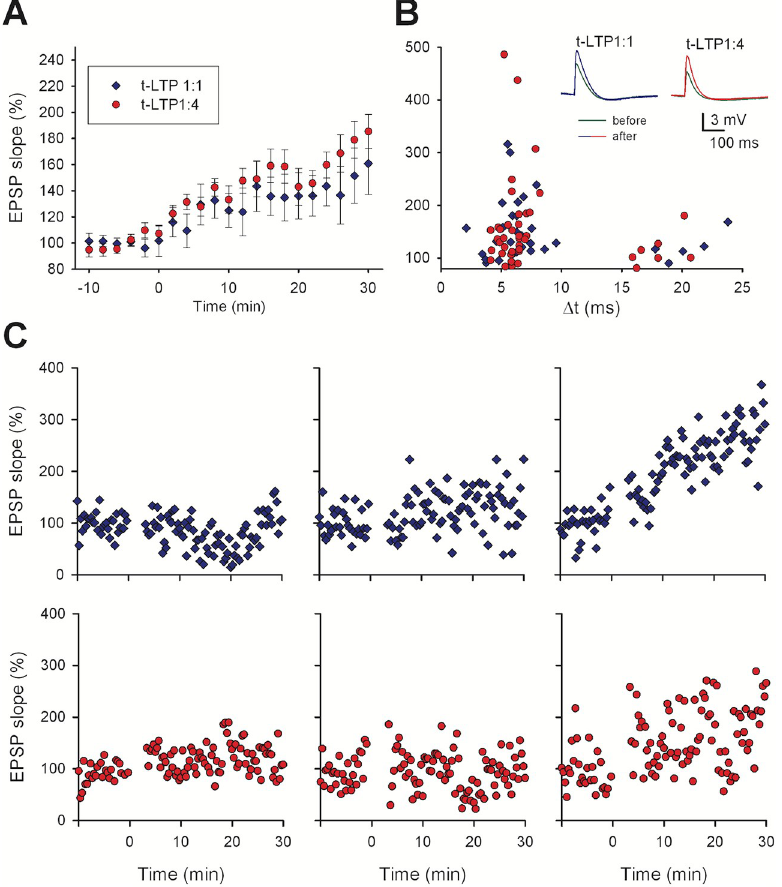
Fig 1. t-LTP expression in whole cell current clamp recordings. A) Average EPSP slope as a function of time (-10 to 0 min: baseline control). The 70x 1:1 t-LTP protocol (blue diamonds, n = 16) or the 25x 1:4 t-LTP protocol (red circles, n = 19) were executed at t = 0 min; in all cases average values ( ± sem) were calculated (bin width: 2 min), for cells with Δ t = 5 − 10 ms . B) Change of EPSP slopes in individual neurons 30 min after t-LTP induction for different Δ t between pre-synaptic activation and post-synaptic action potentials (70x 1:1 t-LTP n = 56, 25x 1:4 t-LTP n = 55; color coding as in panel A; data redrawn from Edelmann et al., 2015 (Fig 1B). The insets show typical somatic recordings of synaptic responses before (green) and after 1:1 t-LTP (blue) or 1:4 t-LTP (red). C) Typical examples of individual EPSP slope recordings following a conditioning period after a 10 min long baseline recording (upper panels paradigm 1:1, lower panels paradigm